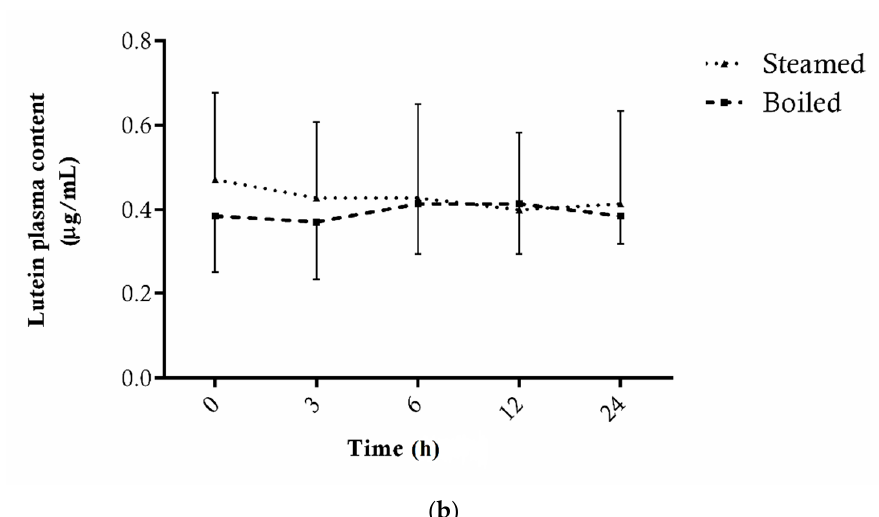
Figure 6. Total β -carotene ( a ) and lutein ( b ) levels in plasma of 7 subjects before (0) and after 3, 6, 12 and 24 h consumption of broccoli cooked with boiling or steaming treatment. Data are expressed as µg/mL of plasma ± SD of three technical replicates .